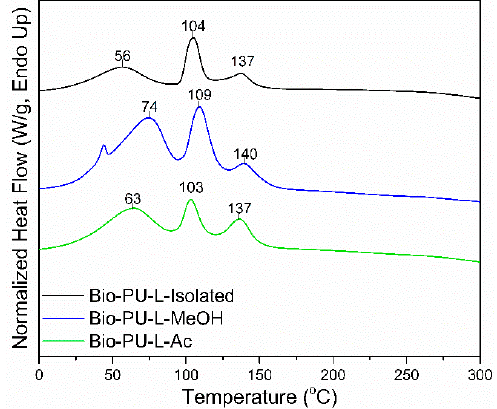
Figure 9. DSC thermograms of Bio ‐ PU resin derived from fractionated lignin. TGA ‐ DTG thermogram is shown in Figure 10. The initial weight loss occurred at a temperature of 60–110 °C, caused by water evaporation and evaporation of chemicals in unreacted lignin during the polymerization process [44,61]. Lignin ‐ based Bio ‐ PU lost 10% of the initial weight with a derivative weight loss of 1.5%/°C at a temperature of 80 °C. There was significant weight loss at temperatures above 160 °C up to 300 °C. The degradation peak occurred at a temperature of 250 °C, which indicated the initial decomposition of the urethane bond with a derivative weight loss of 2.0%/°C. Further degradation occurred at ~350 °C, which is oxidative degradation by the urethane group with a derivative weight loss of 0.75%/°C [66]. At a temperature of 450–600 °C, both the aromatic ring decomposition of lignin and the primary oxidative decomposition of lignin occurred [66,67].